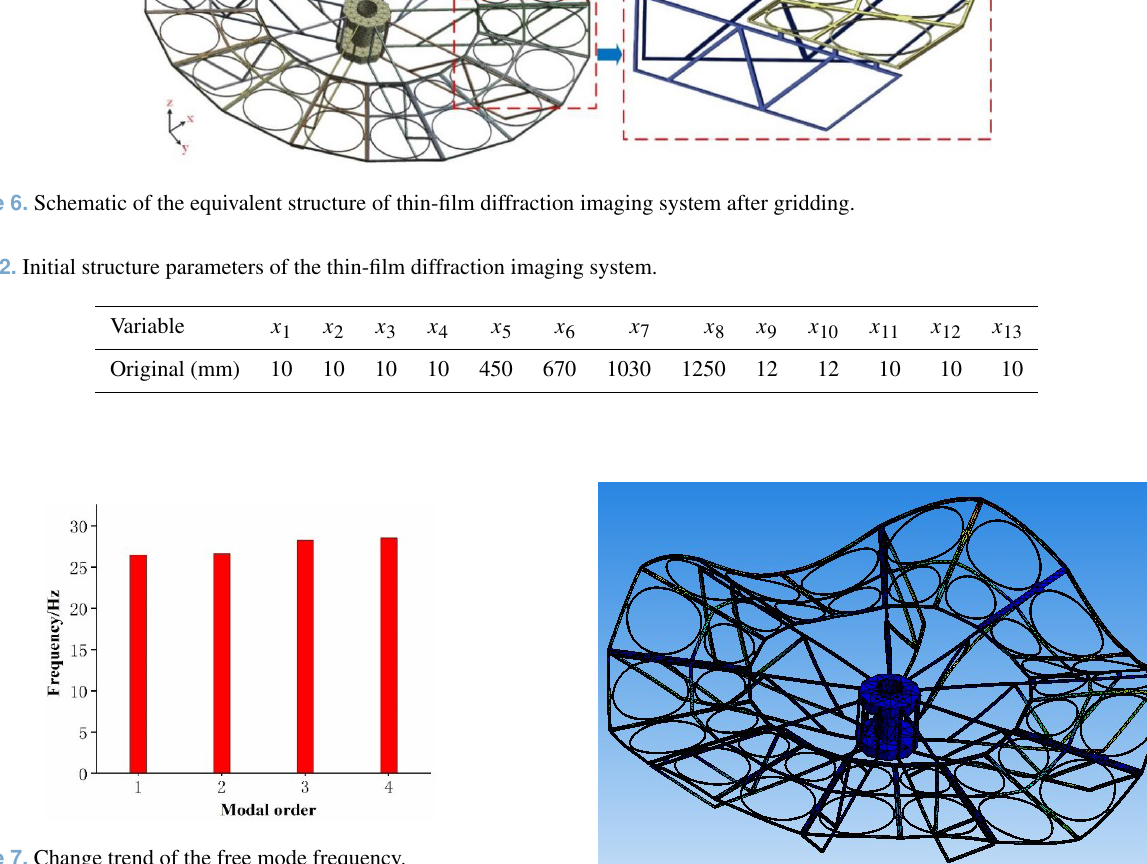
Figure 7. Change trend of the free mode frequency.